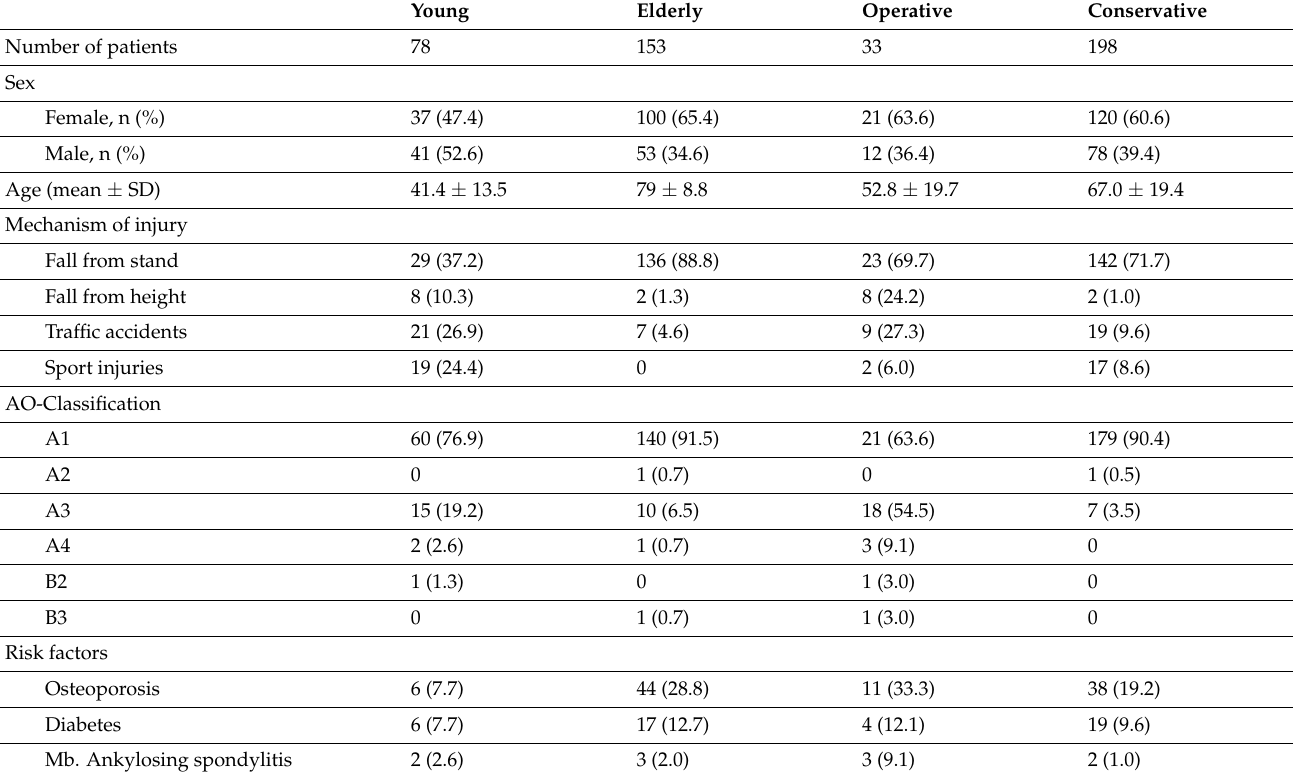
Table 1. Demographic data of patients according to age and treatment. Young